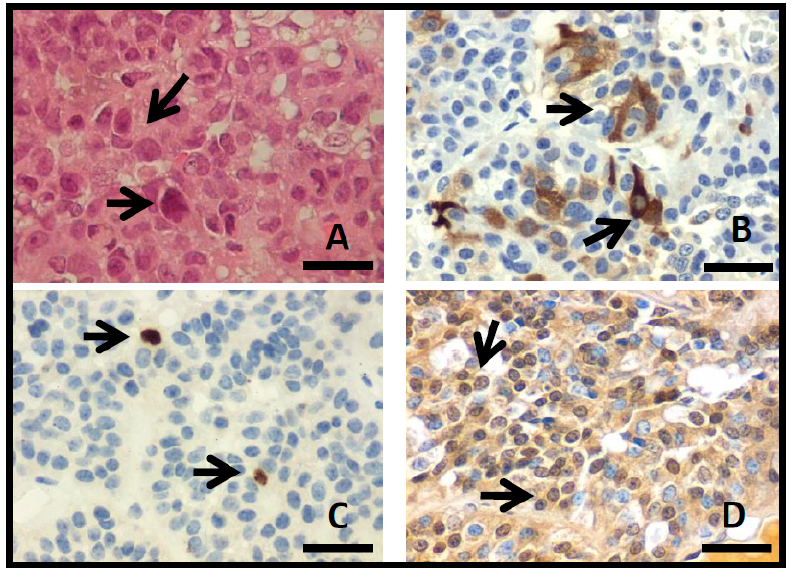
Figure 2. ( A ) Photomicrographs of PA with hematoxylin–eosin stain, showing solid pattern with nuclear pleomorfism (arrows). Immunohistochemistry show cytoplasmic detection to FSH ( B ), Ki-67 nuclear detection ( C ), and p53 nuclear detection ( D ) (arrows; original magnification 400×, scale bar 250 μ m).